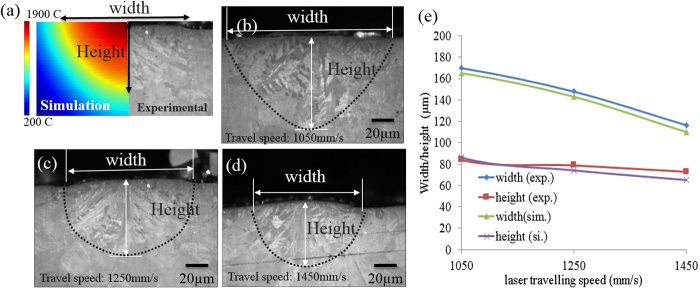
Shape and dimension of the molten pool at the cross-section (YZ plane) after laser incidence.(a) Molten pool definition in simulation and experiment. (b) Molten pool for laser scanning speed 1050 mm/s. (c) Molten pool for laser scanning speed 1250 mm/s. (c) Molten pool for laser scanning speed 1450 mm/s. (e) Comparison of molten pool dimensions obtained from simulation results and experiment results.